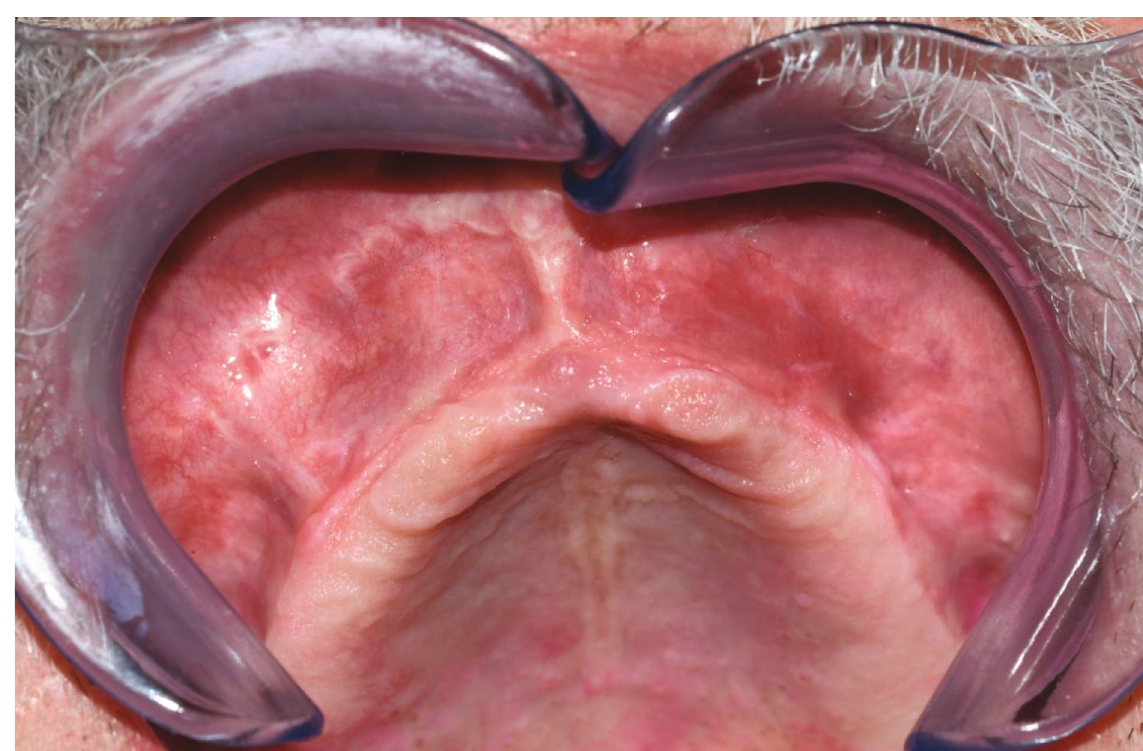
Figure 7: Normal tissue healing at the follow-up assessment after 1.5